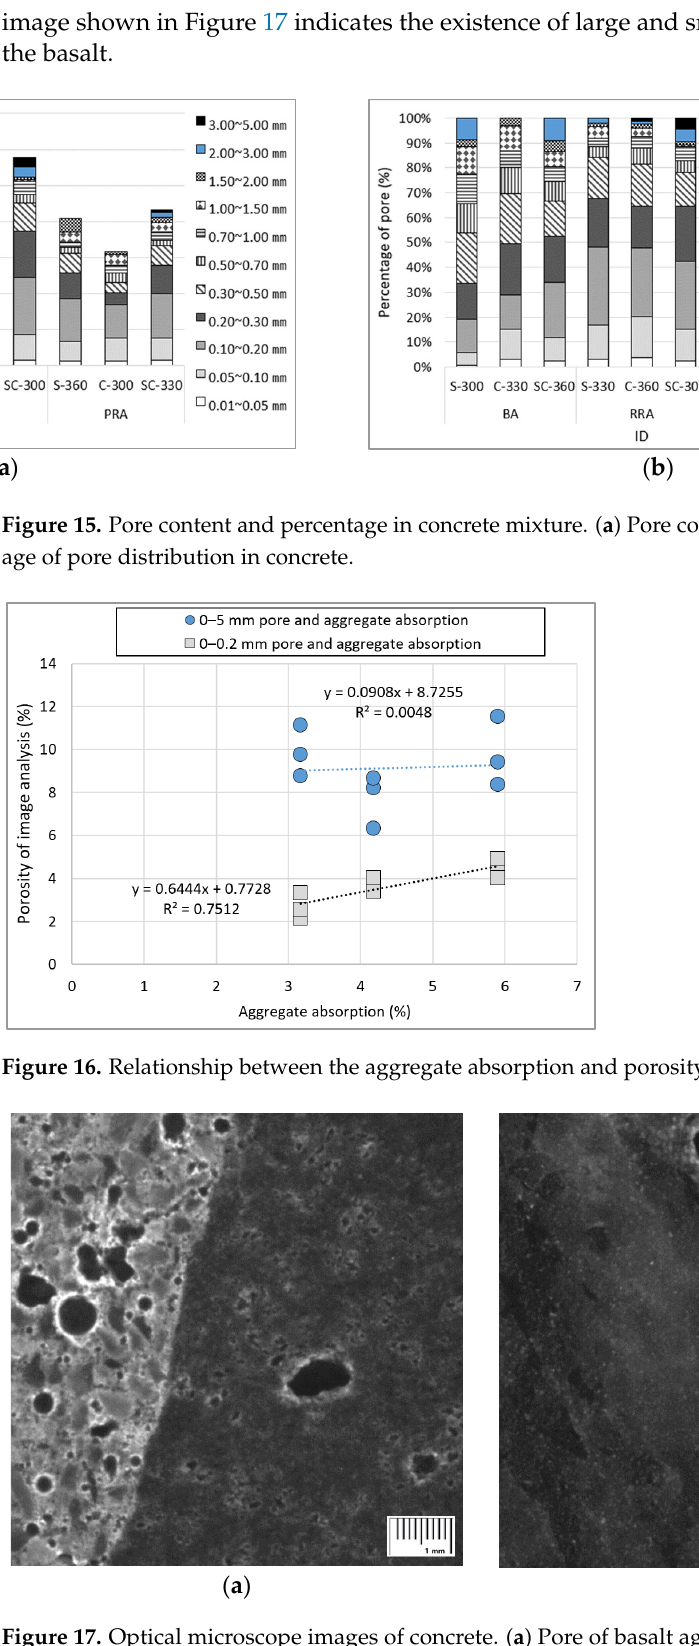
Figure 18. Relationship between the air content of fresh concrete and porosity of hardened concrete. Figure 19. Spacing factor and specific surface area of the concrete. 3.8. Multiple Regression and Correlation Analysis A multiple regression analysis was conducted, as shown in Table 8, to verify the ef ‐ fect of water, cement, BA, RRA, PRA, S sand, and C sand on the carbonation depth. Water, BA, and S sand were removed from the regression model because the tolerance limit was less than 0.1. The regression model was statistically significant (F = 73.336, p < 0.05), and the explanatory power of the regression model was approximately 98.7% (modified R squared was 97.3%) (R 2 = 0.987, adjR 2 = 0.973). Because the Durbin–Watson statistic was